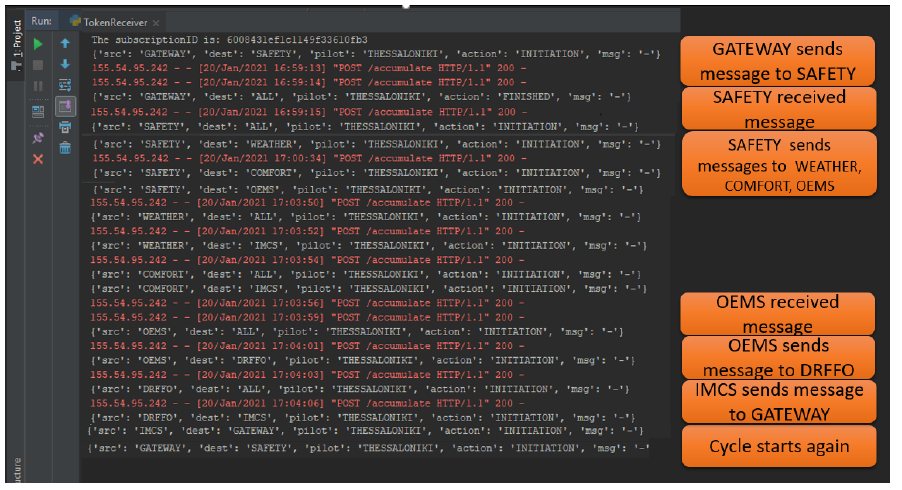
Figure 3. Real-Life Testing of the Communication Channel—Token